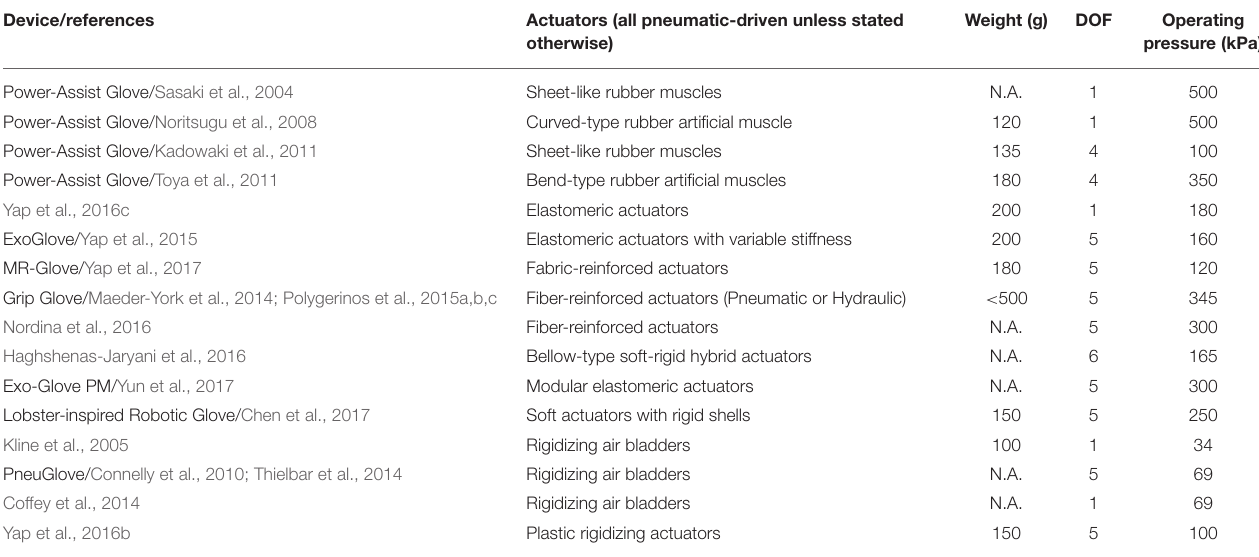
TABLE 1 | Hand assistive exoskeletons driven by inflatable